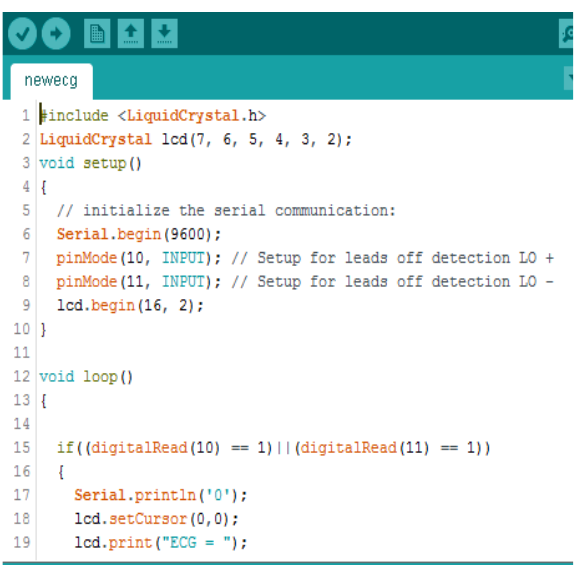
Figure 5. Code for generating ECG